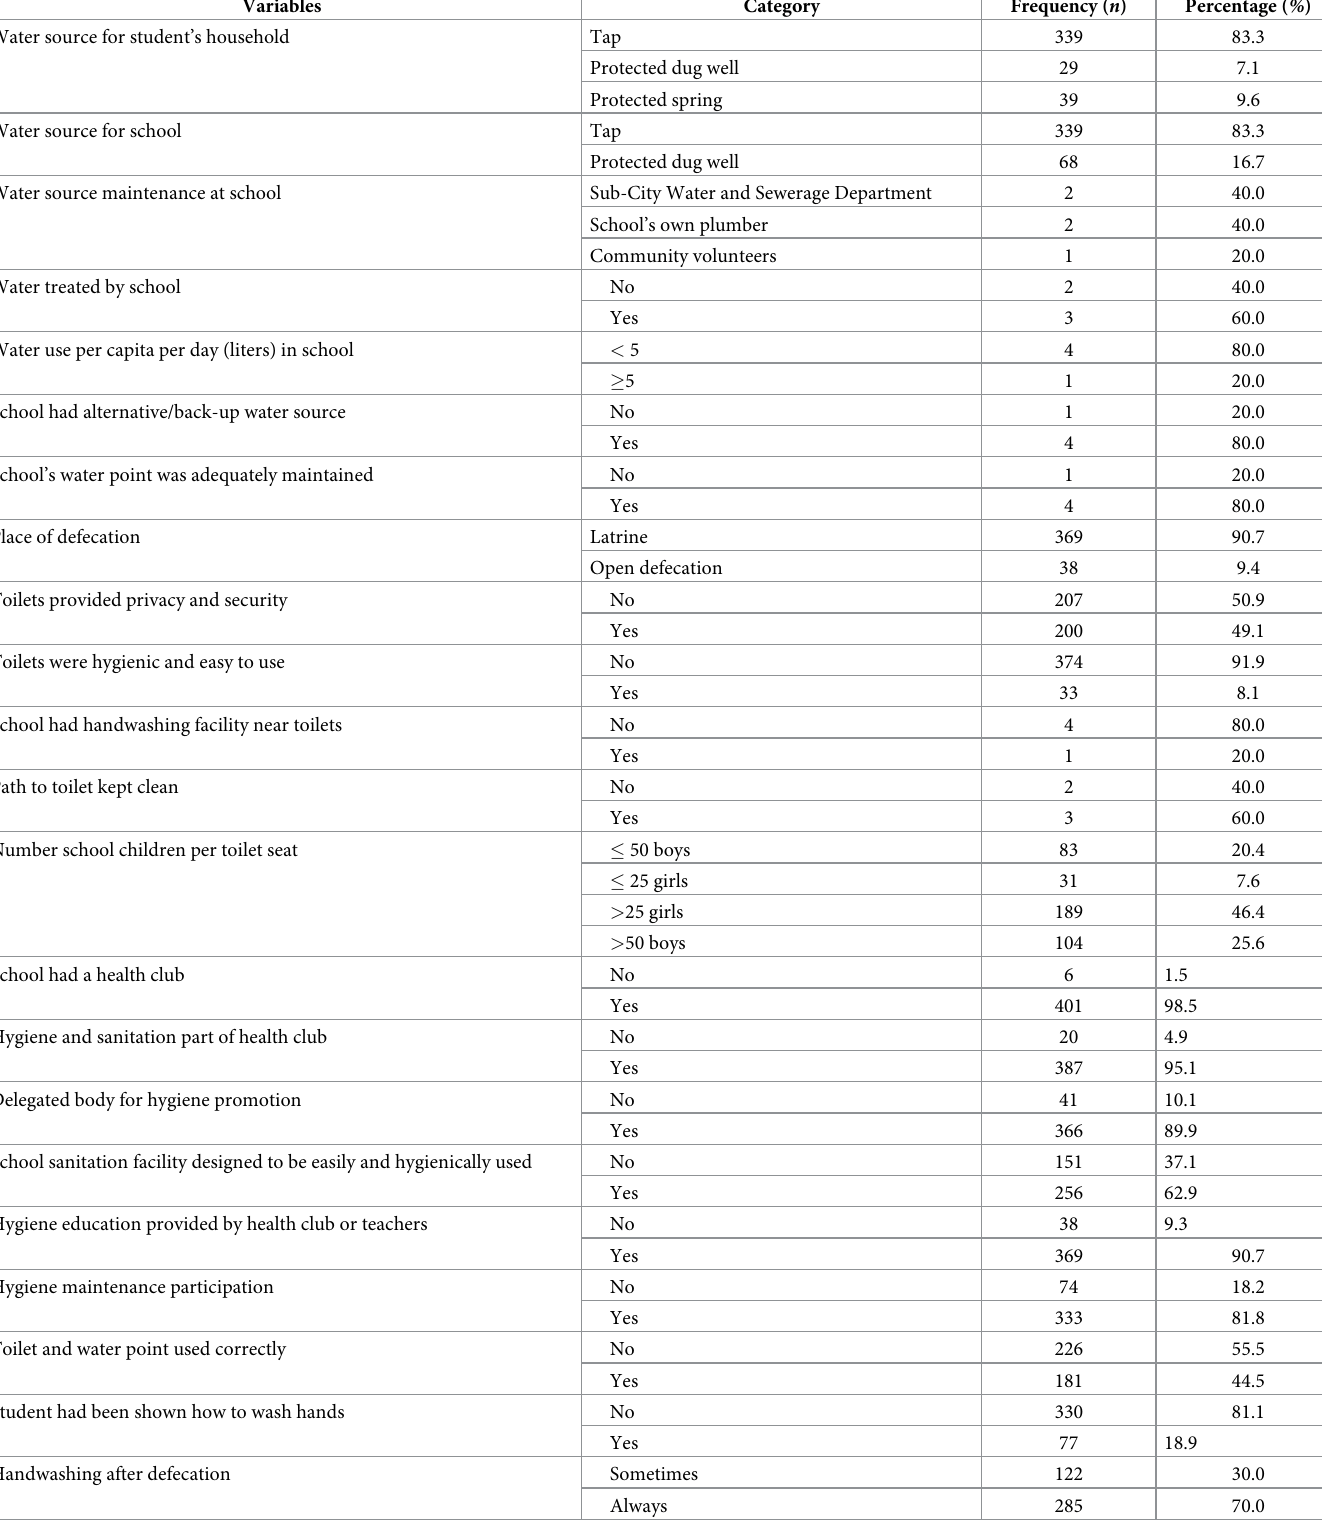
Table 2. Water, sanitation and hygiene conditions in primary schools in Dessie City, Ethiopia, April to June